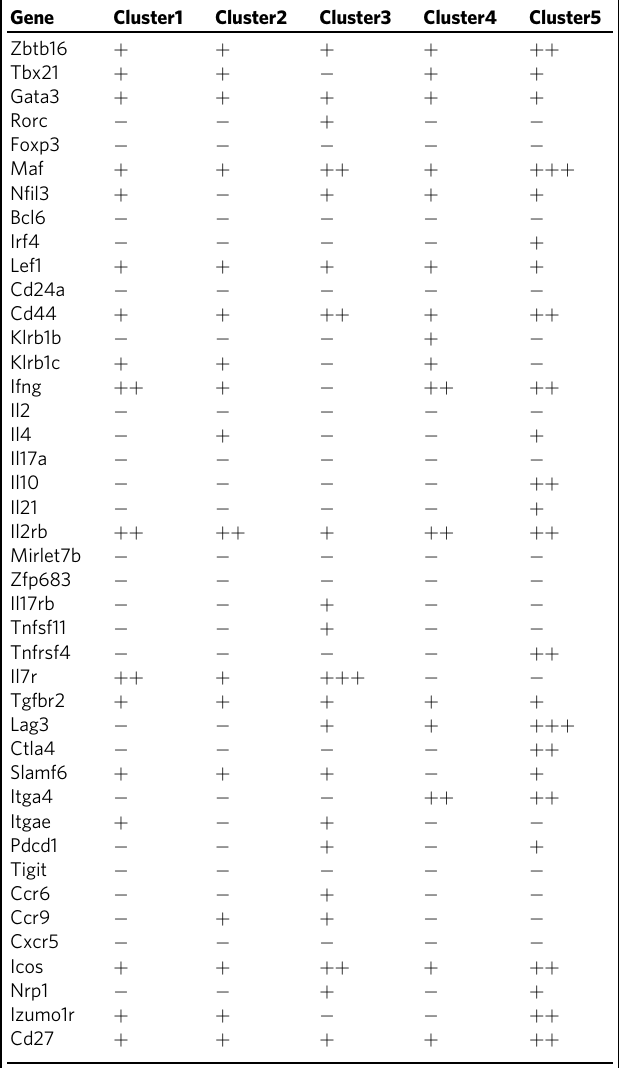
Table 2 LiNKT cell clusters as identi fi ed by